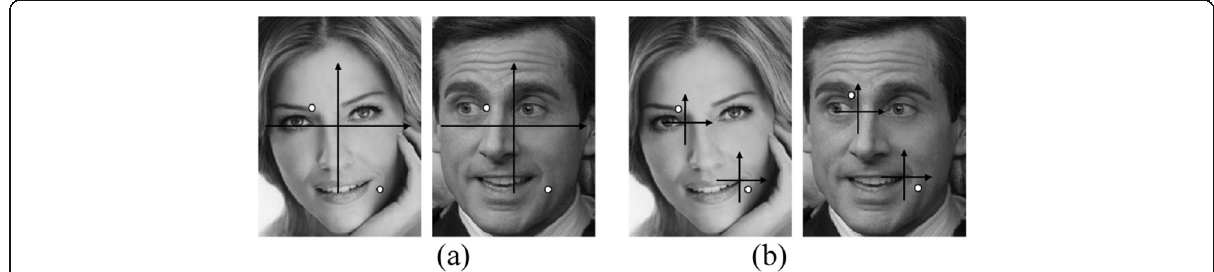
Fig. 2 Shape-indexed features. a Pixels indexed by global coordinates. b Pixels indexed by local